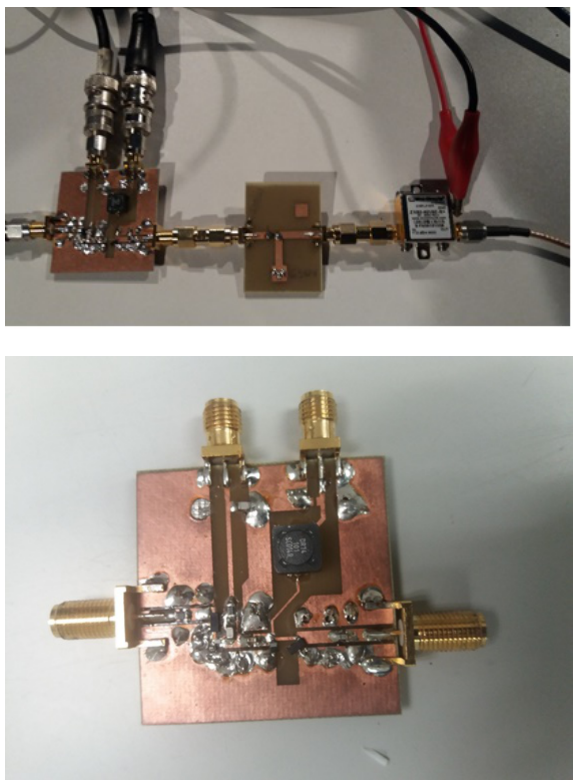
Figure 13: Photo of the proposed radar transmitter circuit. sponse occurred after the target return is received.